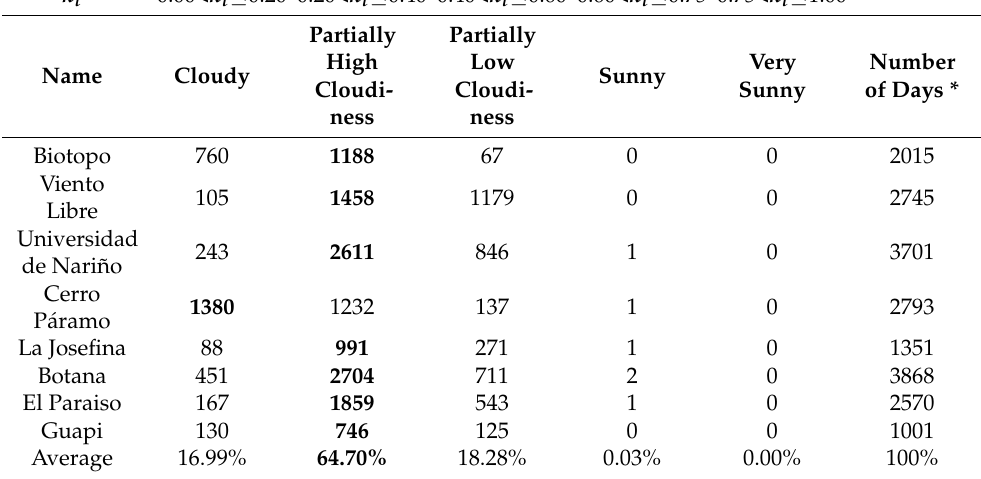
Table 8. Days’ classification according to cloudiness.